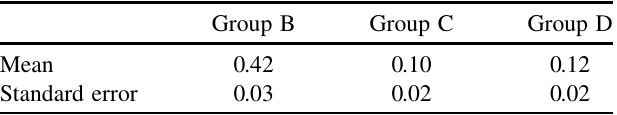
TABLE XIV. Average group presentation grades for self- diagnosis of the pre problem.